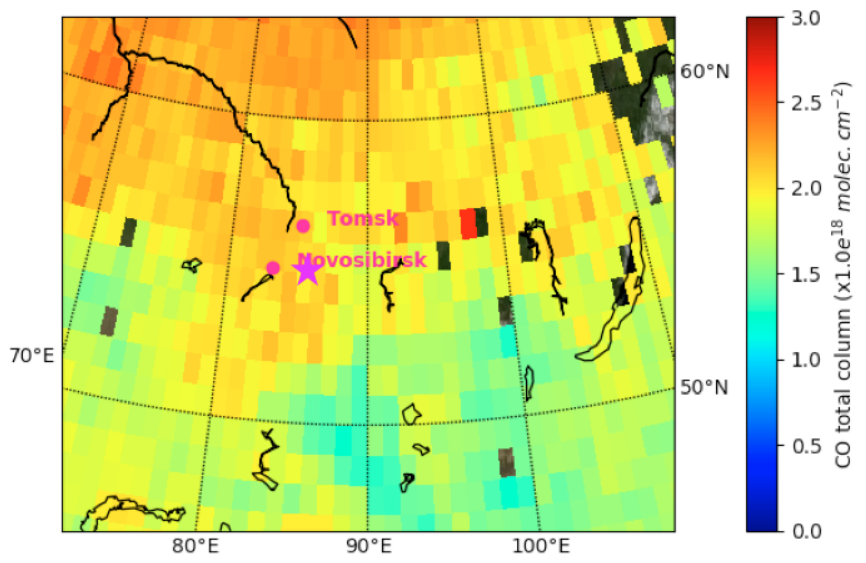
Figure 20. As Figure 5a for the time period 17–20 July 2013. The range of LR values for pollution aerosol is quite large in published papers de- pending on the type of anthropogenic emission, on the season and on the altitude of the aerosol layer. For example, in Europe, Müller et al. [25] obtained 45–60 sr in Leipzig, while Burton et al. [15] proposed a LR range between 53 and 70 sr in North America using their airborne lidar flights around major North American cities and Mexico. In Beijing, Xie et al. [63] found 44 sr for high humidity and heavy pollution and 61 sr for lower humid- ity and moderate pollution level. Ansmann et al. [64] and Heese et al. [65] also found LR generally below 50 sr for the Pearl River delta in China where high pollution and humidity are generally found. At 355 nm, Dieudonné et al. [66] found LR ( > 90 sr) around several cities in Russia higher than the values found by Chazette et al. [67] in Paris (60–77 sr). For this study the LR range is then chosen between 43 and 90 sr to calculate the AOD 532 and backscatter ratio vertical profile for the 1 min average profile shown by the red rectangle in Figure 18. The AOD 532 for the airborne lidar is then 0.154 ± 0.088 (Table 1), while the backscatter ratio decrease with altitude from 2.3 to 1.5. The MODIS AOD 550 for ± 1 h and ± 100 km around the aircraft observations are quite high (0.29 ± 0.054) and remains high but with an elevated standard deviation for a distribution calculated using data ± 24 h around the aircraft observations (0.24 ± 0.15). A CALIOP track is available on 17 July 2013 at 20 UT in the same area at 100 km east of the aircraft position. The CALIOP scattering ratio profile shows two layers with values higher than 1.6 below 1.3 km and at 2.3 km (Figure 21). The maximum value at 1.5 km is similar to the airborne lidar backscatter ratio. The CALIOP color ratio is between 0.3 and 0.5 in the layer at 2.3 km but increase significantly up to 0.7 below 1 km (Figure 21). This implies a significant contribution of the coarse mode aerosol compared to the case of flaring emissions. The CALIOP AOD 532 is 0.18 ± 0.06 with a lidar ratio of 70 sr, i.e., an AOD 532 similar to the aircraft observation. As for the fresh fire case, it is difficult to conclude about the MODIS AOD 550 being larger than the airborne or spaceborne lidar AOD 532 nearby the aerosol emission source even though the measurements are separated by less than 1 h and 100